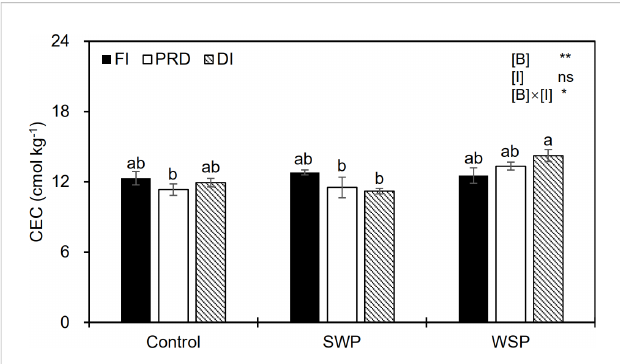
FIGURE 2 Soil cation exchange capacity (CEC) status of maize plants exposed to different biochar (Control, SWP, and WSP) and irrigation (FI, DI, and PRD) treatments. Values are the mean ± standard error ( n = 4). * and ** indicate signi fi cant levels at p < 0.05 and p < 0.01, respectively. ns indicates no statistical signi fi cance. Different letters in the bars